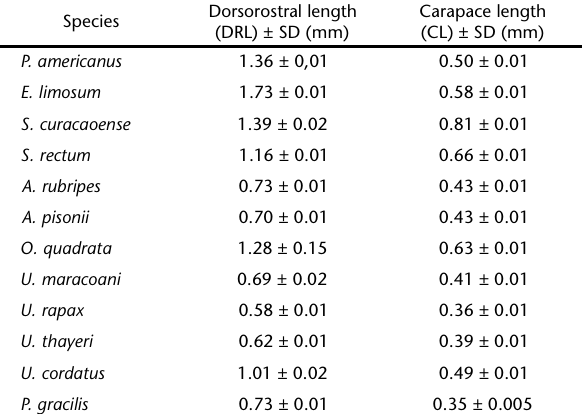
Table II. Measurements of zoea I of the species described in this study.